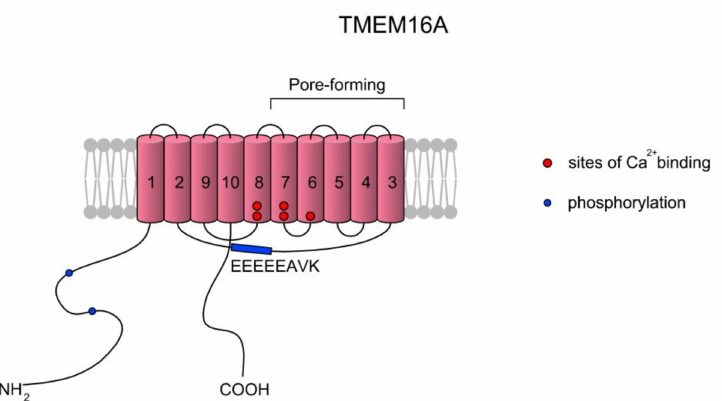
Figure 4. A simplified topology of the TMEM16A monomer. Each monomer has 10 TMs. The ion conduction pore of TMEM16A is formed by TMs three to seven in each subunit, and thus the CaCC features two pores [96,97]. As summarized in a review of Ji et al. [97], the activation of TMEM16A is gated by two main mechanisms: voltage (Vm) and low concentrations of Ca 2+ (<600 nM) via the EEEEEAVK motif in the TM2–TM3 loop. Contreras-Vite et al. [98] proposed a